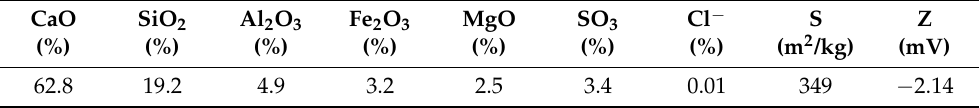
Table 2. Characteristics of cement particles (Portland cement type I 42.5 R).